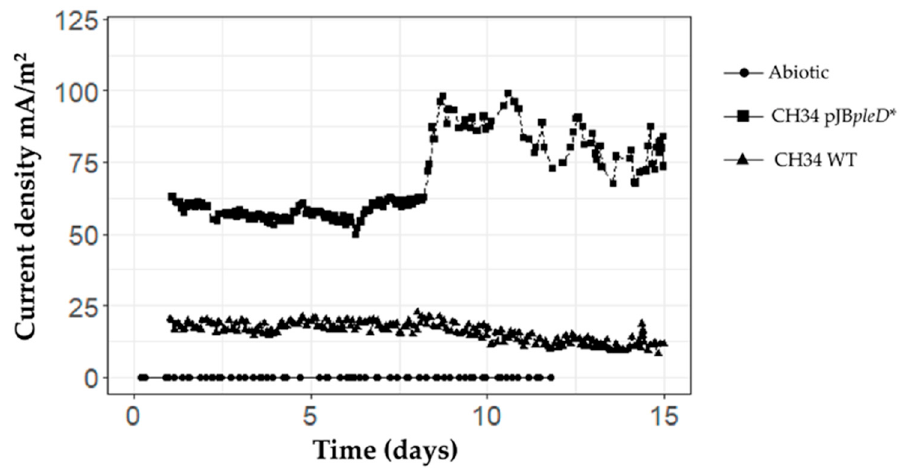
Figure 2. Increased bioelectrogenic activity of the genetically modified C. metallidurans strain CH34 pJB pleD * in BESs. C. metallidurans CH34 pJB pleD * showed an increase in current densities compared with wild-type strain CH34. In the abiotic control, current densities remained stable between 0–3 mA/m 2 during the whole experiment.